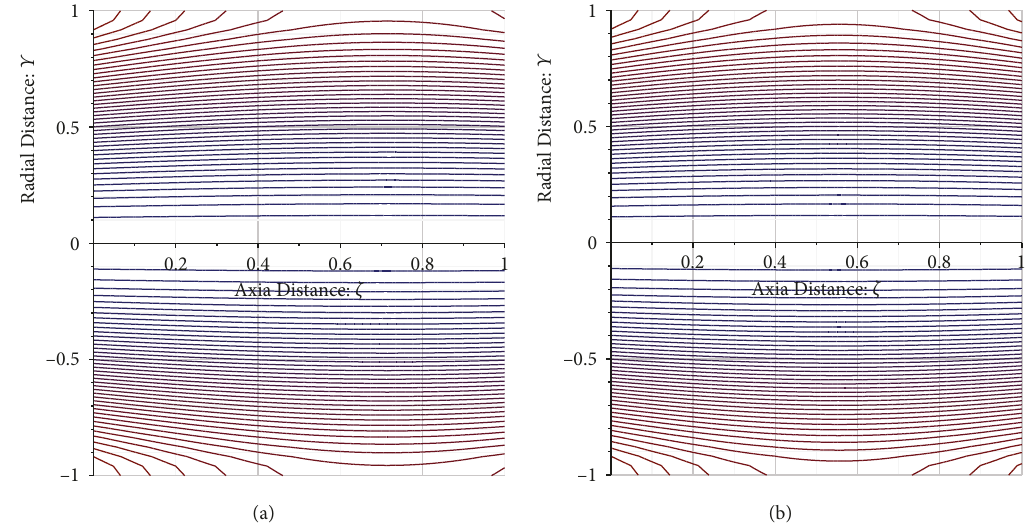
Figure 7: Stream lines for W � 0 . 5 × 10 − 5 and different values of S . (a) S � − 0 . 7 × 10 − 5 . (b) S � − 0 . 9 × 10 − 5 0